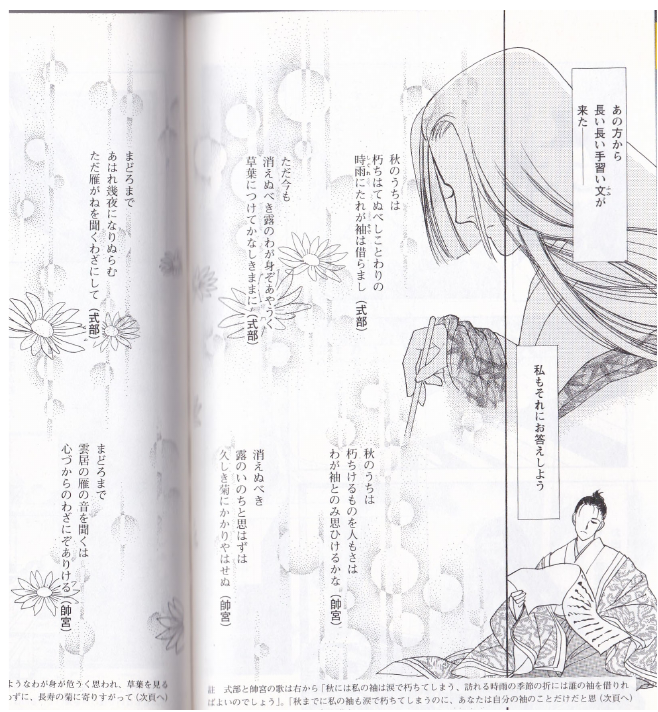
Figure 14. The woman and the Prince exchange poems (Igarashi, Izumi